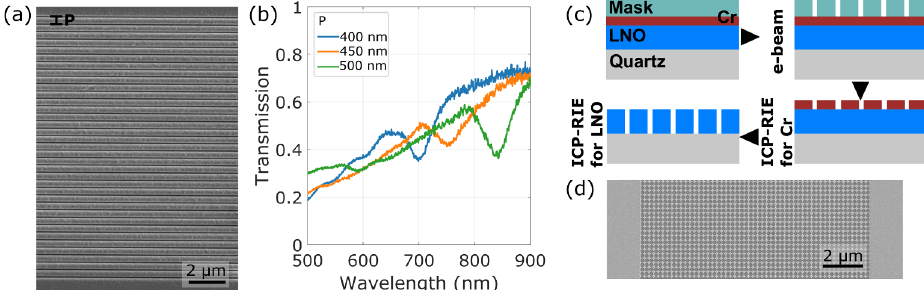
Figure 2. (a) SEM image of LNO gratings fabricated by FIB. (b) Measured transmission of the LNO gratings. (c) Schematic flow of the ICP fabrication protocol of LNO metasurfaces. (d) SEM image of a metasurface after the ICP-RIE for chromium